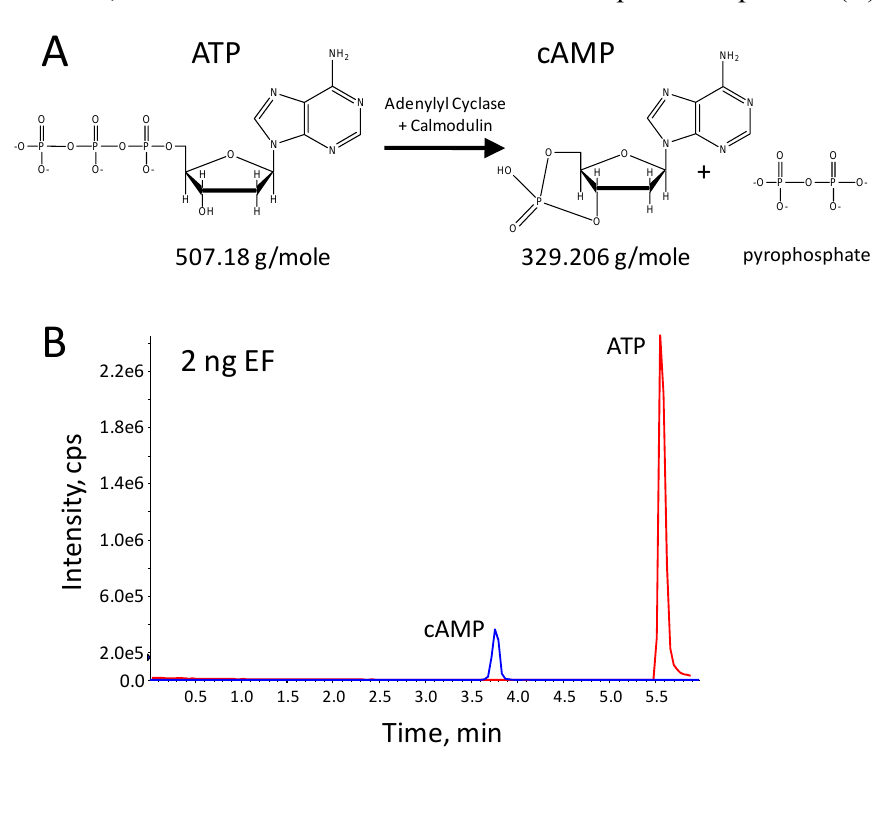
Figure 5. The structures of the edema factor (EF) substrate adenosine triphosphate (ATP) and reaction product cyclic adenosine monophosphate (cAMP) (A). Chromatogram for a 2 h reaction with 2 ng EF in the presence of 1 mM ATP generated by LC-ESI-MS/MS in positive ion mode, for the 508 ATP ion and 329/136 cAMP precursor/product